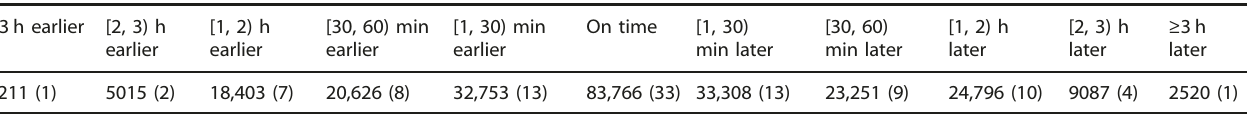
Table 2. Number of instances for each bedtime deviation category (%).